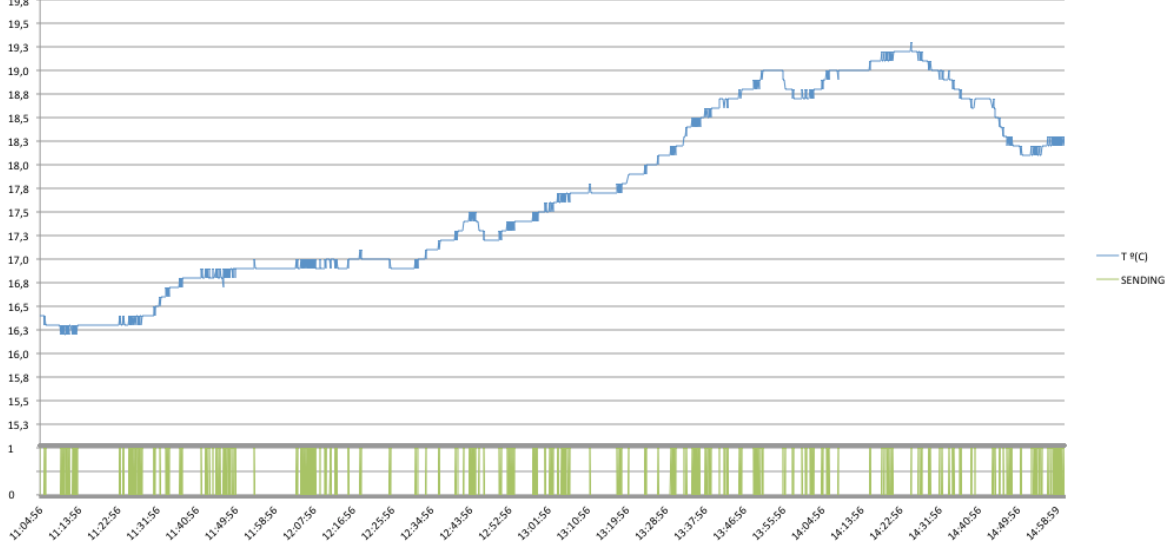
Figure 30. Temperature measurements notifications with Observe